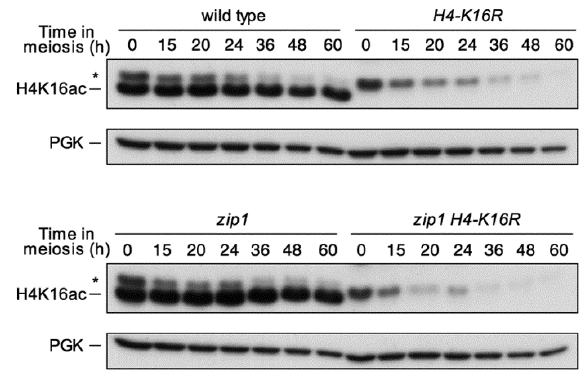
FIGURE 1: H4K16 acetylation remains unaltered during both normal and perturbed meiosis. Western blot analysis of H4K16 acetylation throughout meiosis in wild-type (DP421) and zip1 (DP422) cells. The H4-K16R (DP994) and zip1 H4-K16R (DP995) mutant strains were used as controls for antibody specificity. PGK was used as a loading control. Asterisks mark a non-specific band.